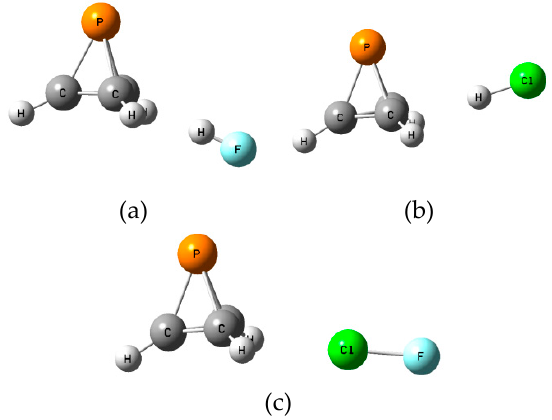
Figure 5. Structures of ( a ) FH:P(CH) 3 , ( b ) ClH:P(CH) 3 , and ( c ) FCl:P(CH) 3 isomers B .